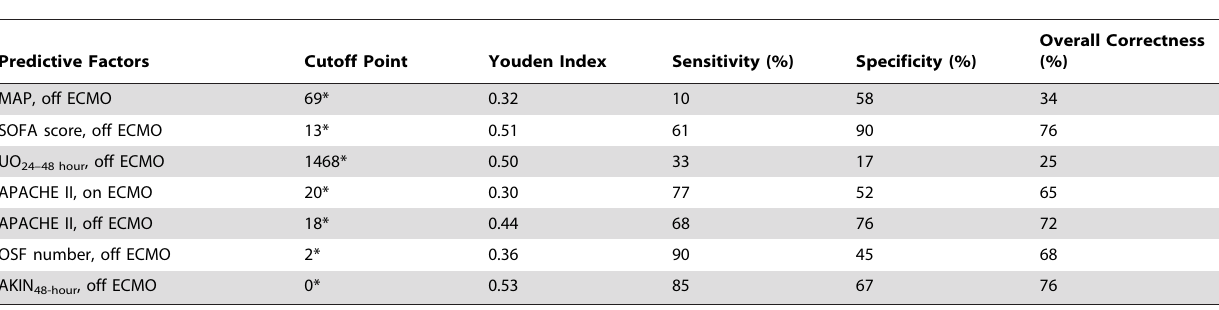
Table 5. Prediction of subsequent hospital mortality after ECMO